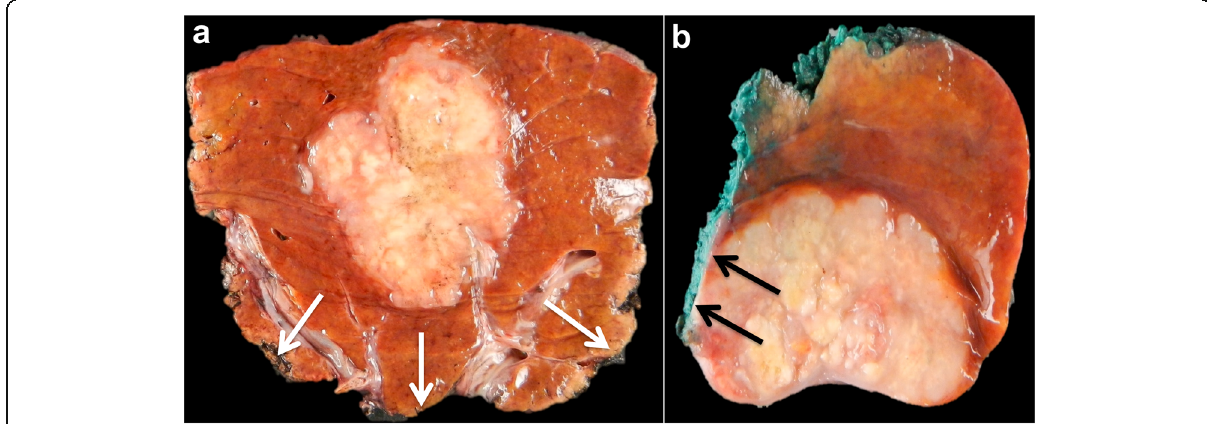
Fig. 9 Resected specimen of hepatic metastasis showing a macroscopic evaluation of the surgical margin. The parenchymal transections are marked with ink. In ( a ), the surgical margins are wide, the metastasis is far from the transection line (white arrows), corresponding to a R0 resection. In ( b ), the surgical transection clearly passes through the lateral border of the metastasis (black arrows), corresponding to a R1